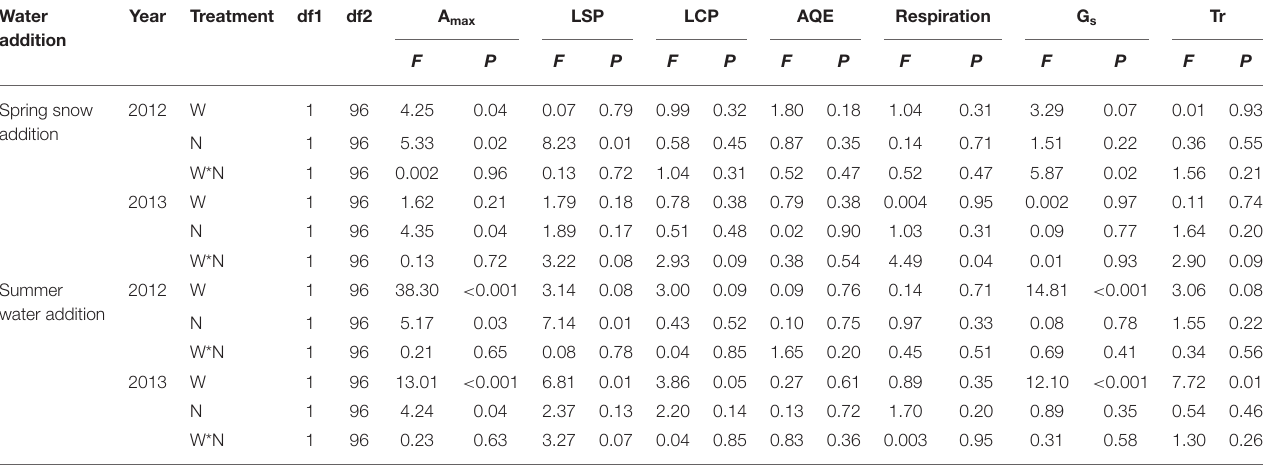
TABLE 2 | Results ( F- and P -values) of mixed-model analysis on the effects of water (W; including spring snow and summer water), N application (N), and their interactions on the maximum photosynthetic rate (A max ), light saturation point (LSP), light compensation point (LCP), maximum apparent quantum yield (AQE), respiration, stomatal conductance (G s ), and transpiration rate (Tr) of Stipa grandis in 2012 and 2013. Water